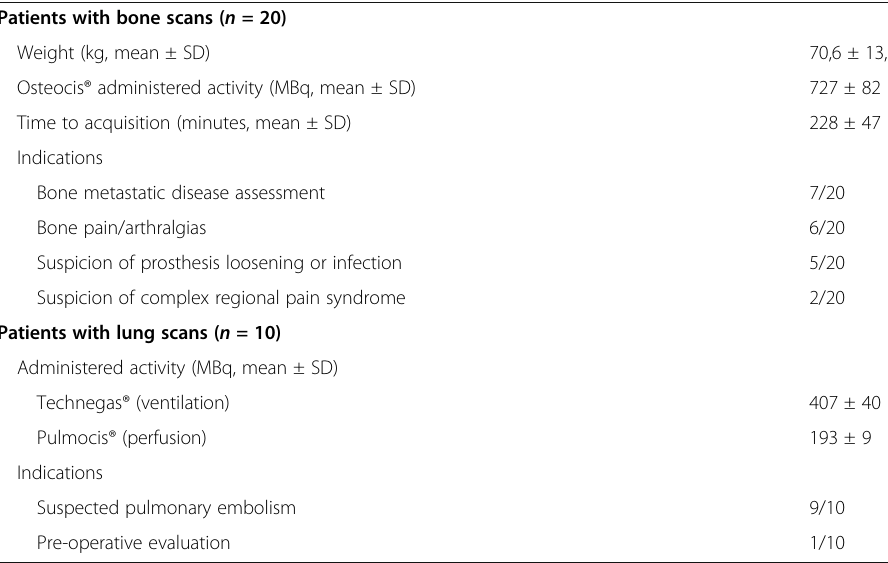
Table 1 Characteristics of the patients Patients with bone scans ( n = 20) Weight (kg, mean ±